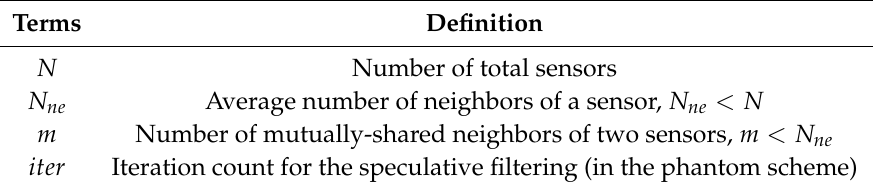
Table 2. Terms and definitions.